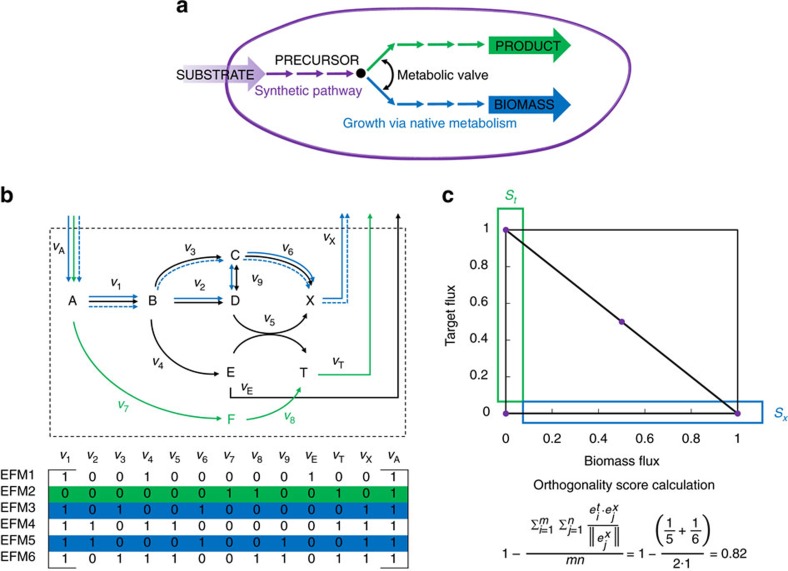
The ideal structure of an orthogonal pathway in a cell.Green corresponds to the EFMs that produce the desired target chemical and are described by the set St. Blue corresponds to the EMFs that produce biomass and are described by the set Sx. (a) The branched design is characteristic of this type of orthogonal structure. (b) We show a hypothetical small network where A is converted to products E, X (biomass) and T (target compound). The mathematical representation of this network is described by the EFMs shown below the network in a Boolean matrix, where blue lines are the biomass-only forming EFMs (3 and 5) and green is the product-only forming EFM (2). This type of network structure can be described as an orthogonal network because A can be converted to T by reactions v7 and v8 and the metabolic valve v1 can be modulated to be turned on or off. Traditional metabolic engineering strategies would attempt to drive flux towards the desired product, T, by growth coupling T to X. For example, this may require the deletion of v3, v6 and/or v7. Orthogonal metabolic-engineered strategy relies on the thermodynamics for converting A to T and manipulating v1 to control flux towards biomass. An example calculation of the orthogonality score is shown. (c) We show the production envelope for the network containing the EFMs that describe that solution space. The functionalities of interest of the network are shown in the green and blue boxes. These represent the desired subspaces Sx containing the elementary modes (EFM3, EFM5 shown in blue) and St containing the modes  (EFM2 shown in green). The orthogonality score is calculated based on the similarity of these subspaces.